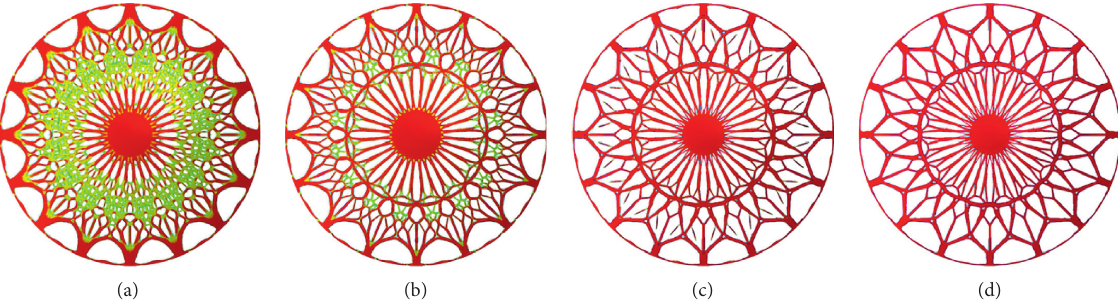
Figure 3: Optimization results of a spherical shell (project view). (a) 40 th iteration. (b) 60 th iteration. (c) 80 th iteration. (d) 95 th iteration.